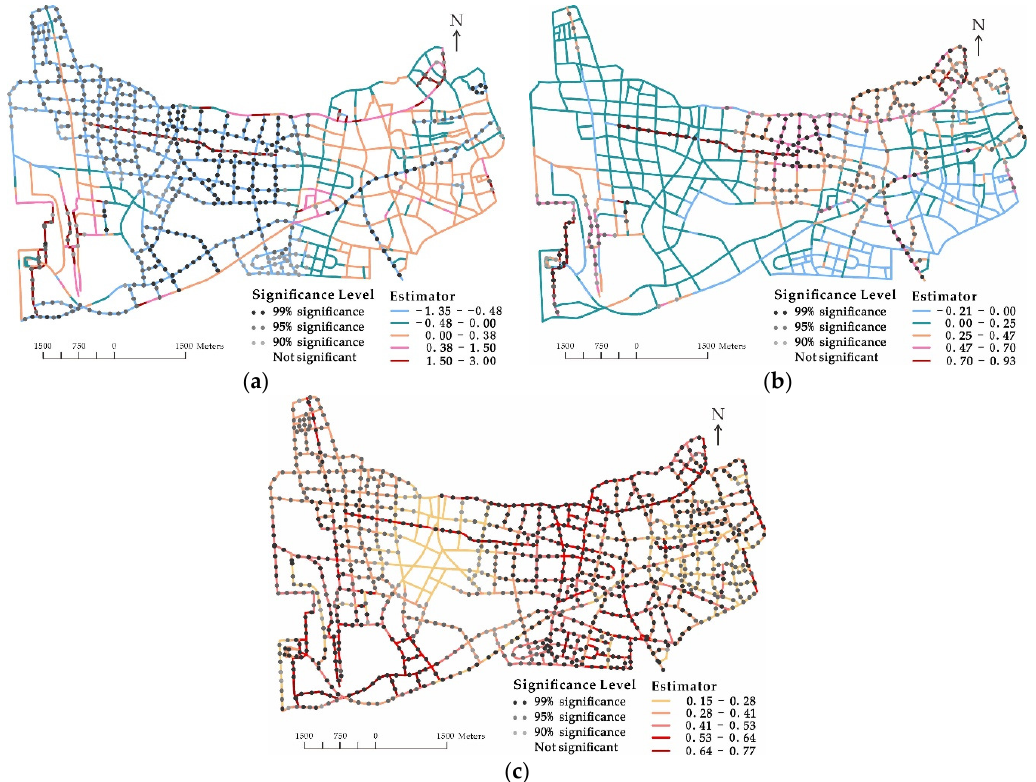
Figure 2. Spatial distribution of coefficient estimations and significance levels by exposure variable. ( a ) vehicle_km and ( b ) num_elder.